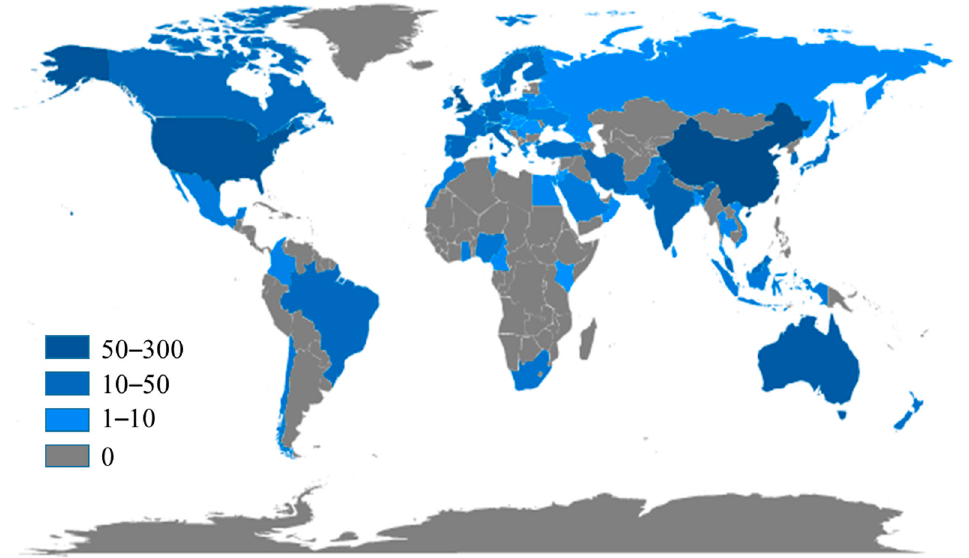
Figure 4. Worldwide publications on CSCM .